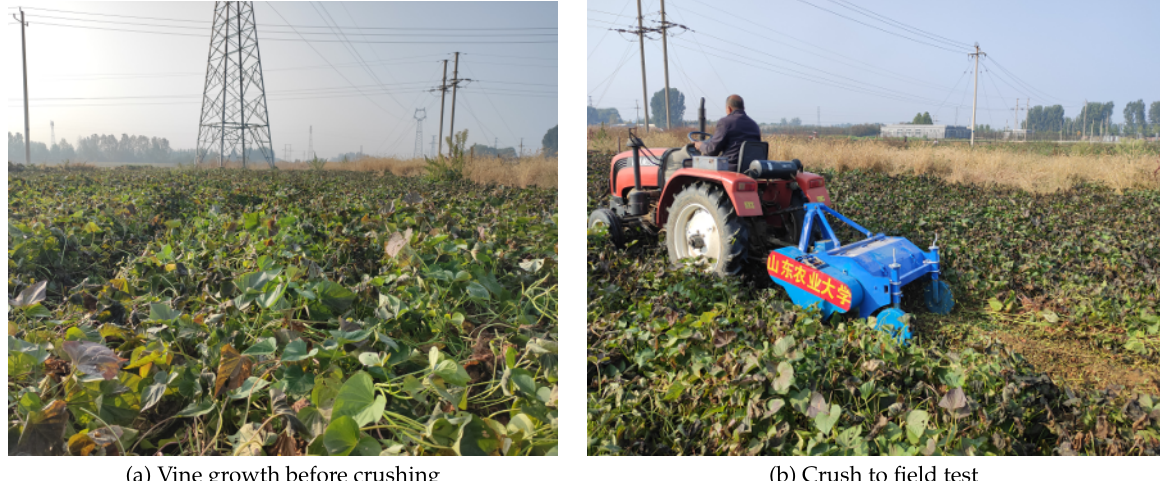
Fig. 10. Test on double-roller sweet potato vine crushing and returning Table 2. Test factors and coded values Picking Coded values